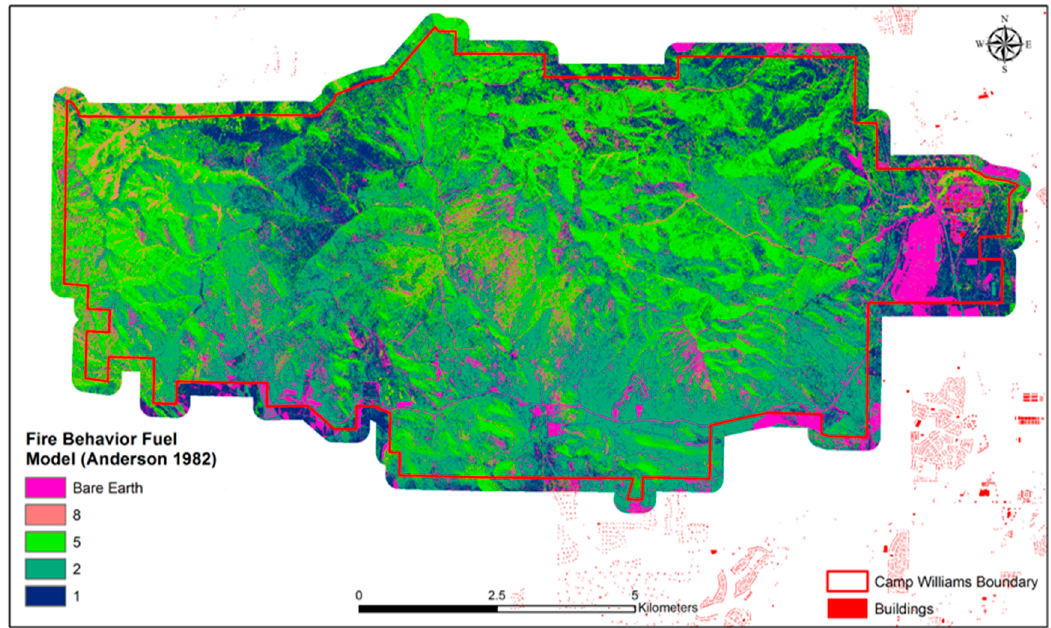
Figure 6. Map of Anderson [32] fire behavior fuel models for Army Garrison Camp Williams as predicted using random forests at 0.5 m resolution.